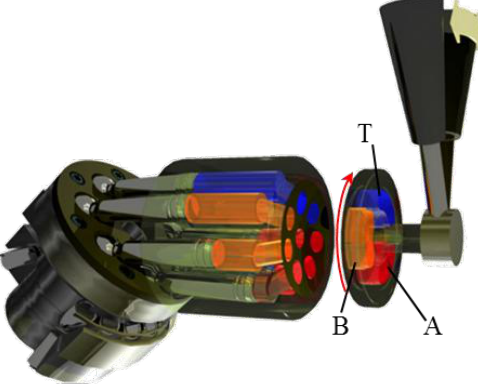
Figure 2. The hydraulic transformer of INNAS Company BV.